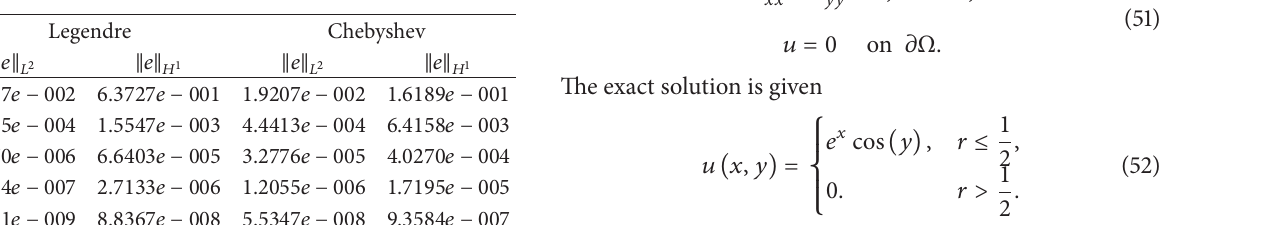
Table 7: Error discretization for 𝐶 = 0.1 and 𝑏 = 10 for Example